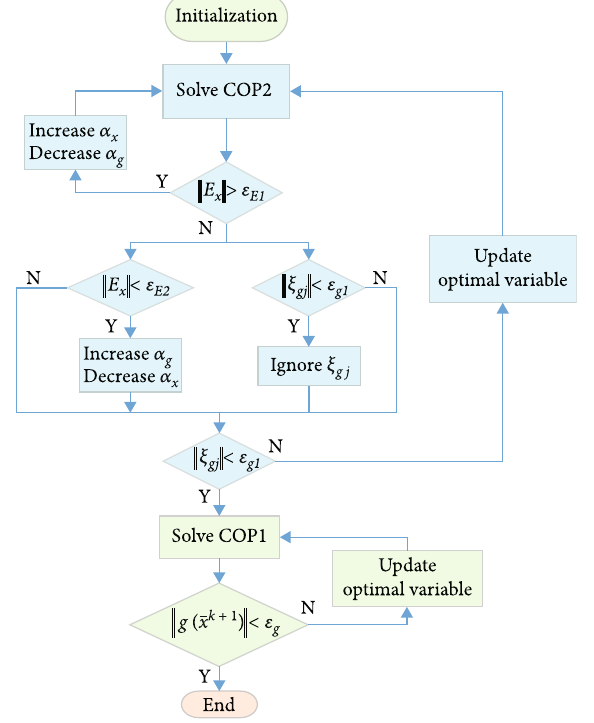
Figure 2: Trajectory optimization